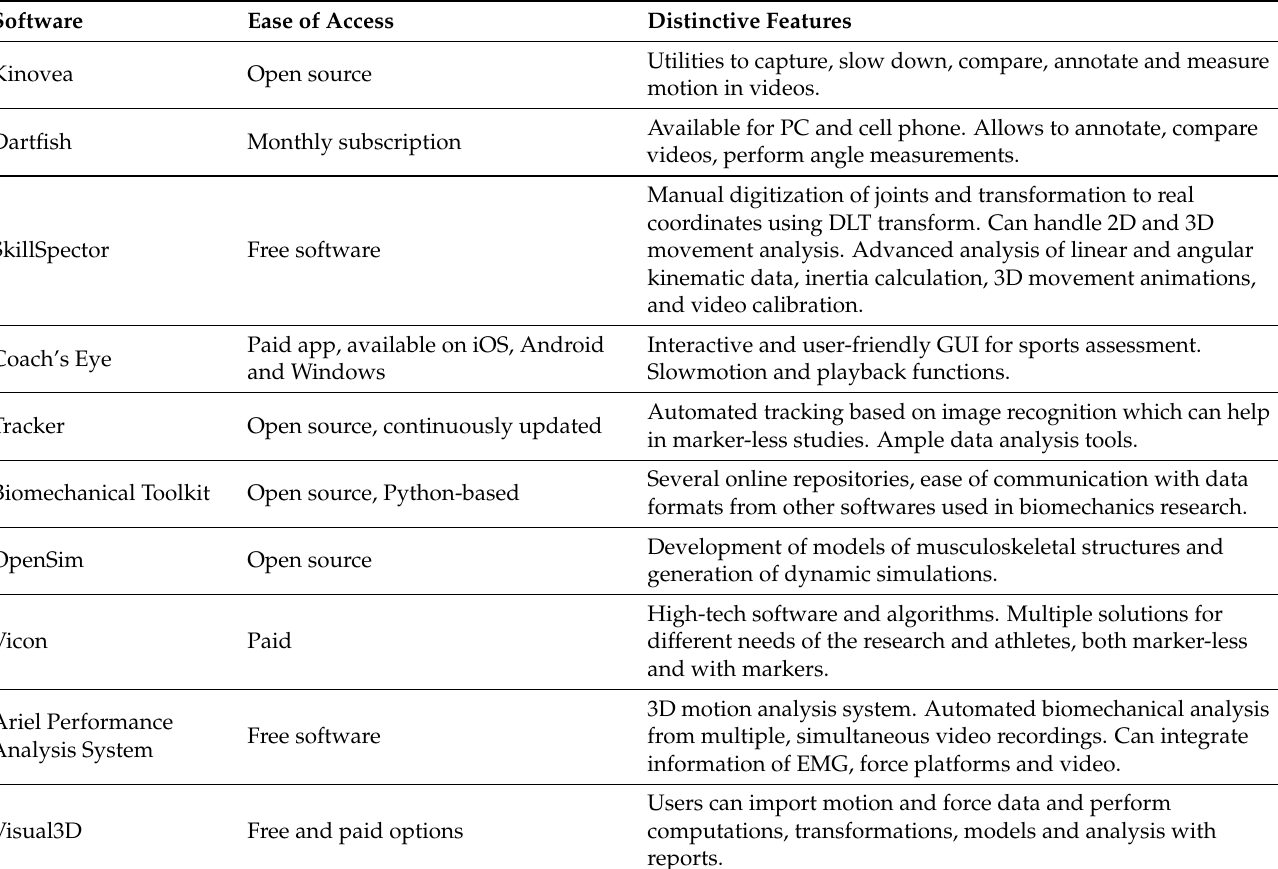
Table 2. Softwares used for Video-based Biomechanics research and their distinctive